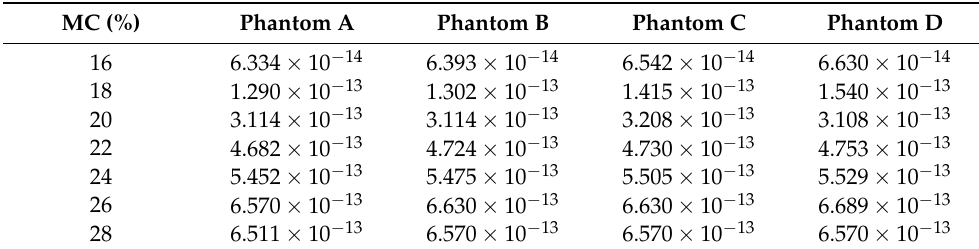
Table 5. Percentage of maximum pixel value using Tikhonov Regularization